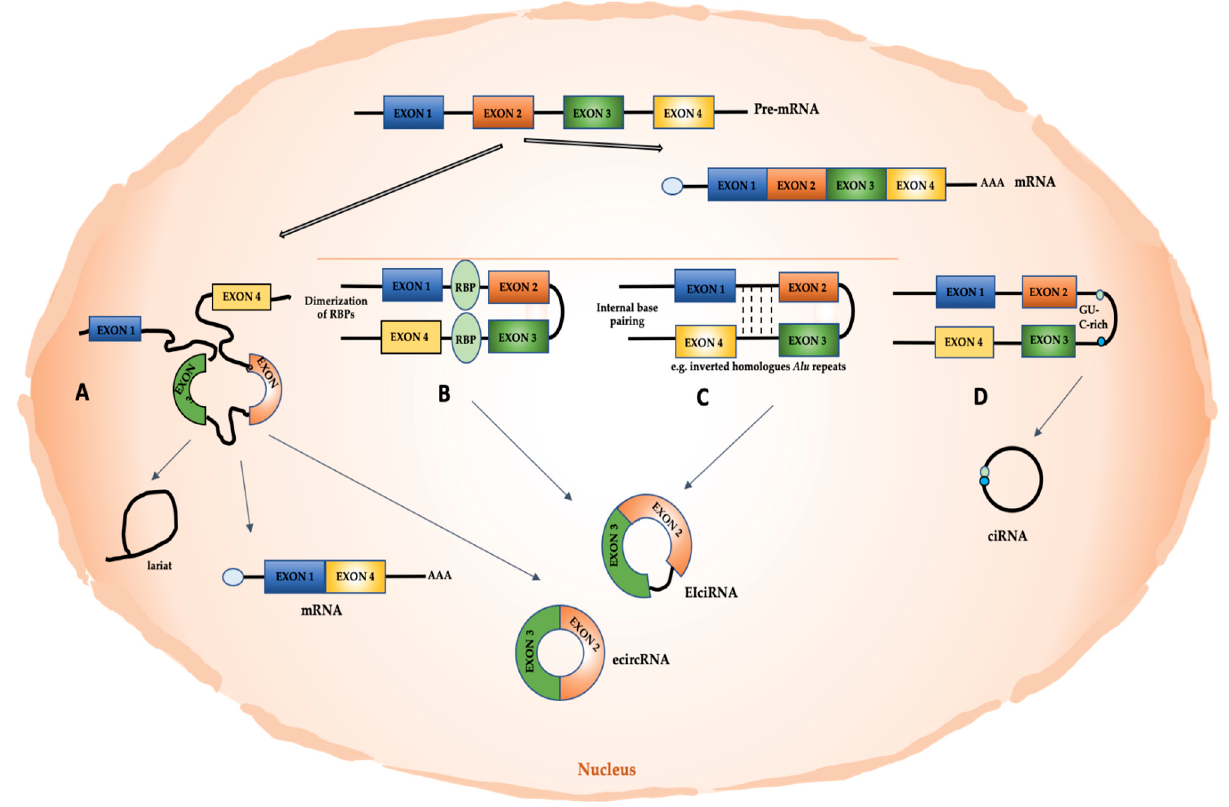
Figure 1. Biogenesis of circular RNAs. Pre-mRNA can be processed via canonical splicing; however, a lariat-driven RNA circularization can result in the formation of ecircRNAs, intron lariat, and linear mRNAs ( A ). Circularization in EIciRNAs or ecircRNA can depend on the bridge formed by RBP pairing ( B ) or be triggered by internal base pairing (e.g., for inverted homologous Alu repeats) ( C ). Lariat formation of ciRNAs can be favored by GU and C-rich elements ( D